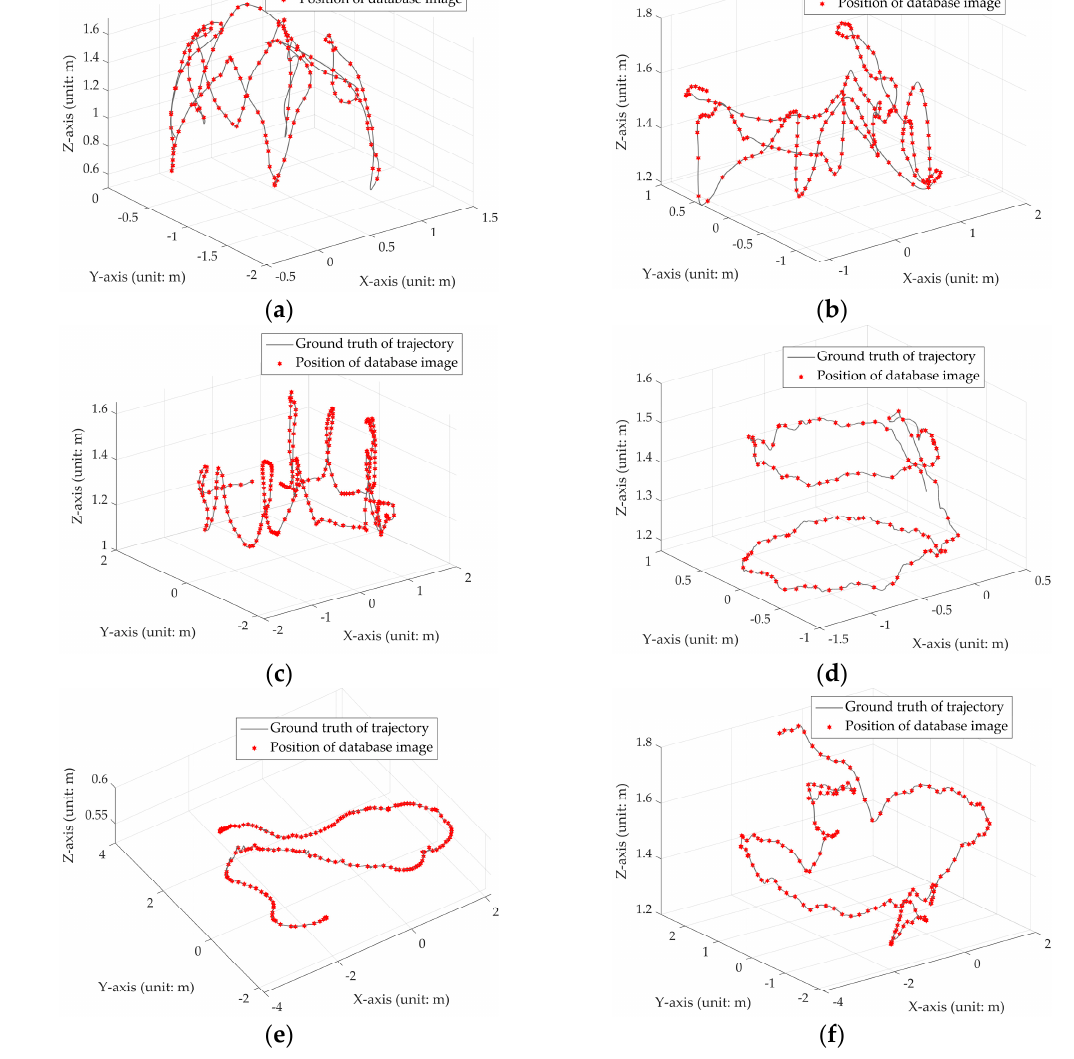
Figure 9. The results of RGB-D database construction for six sequences: ( a ) freibuig1_plant, ( b )